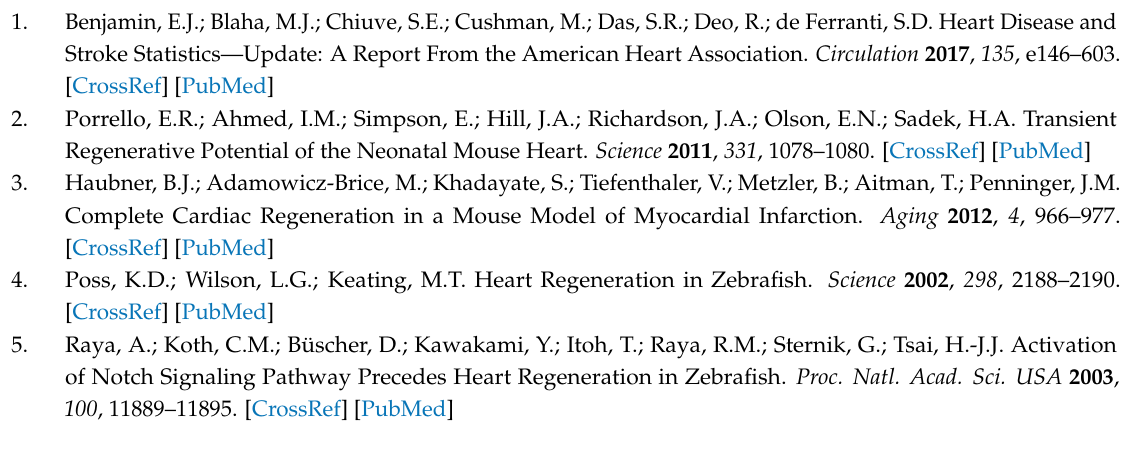
Figure S1: Overview about the ages of fish used in the experiments. Figure S2: Quality control plots of mRNA samples. Figure S3: Quality control plots of mRNA samples. Figure S4: Principal component analysis before and after batch correction using surrogate variables. Figure S5: Dynamics of the top 10 miRNAs with the most target genes during zebrafish heart regeneration. Figure S6: Read counts in H9c2 cell line of the top miRNAs Ontology. Table S2: Responses using FisherTest with Gene Ontology. Table S3: miRNA and mRNA interactions. Table S4: miRNA analysis using FisherTest with Gene